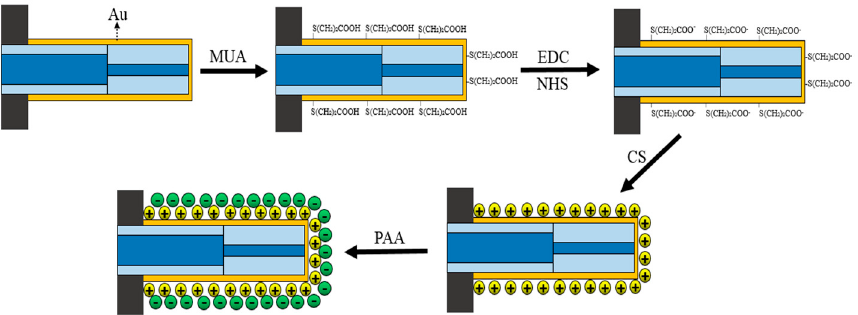
Figure 5. Coating process of the Hg 2+ sensitive film.